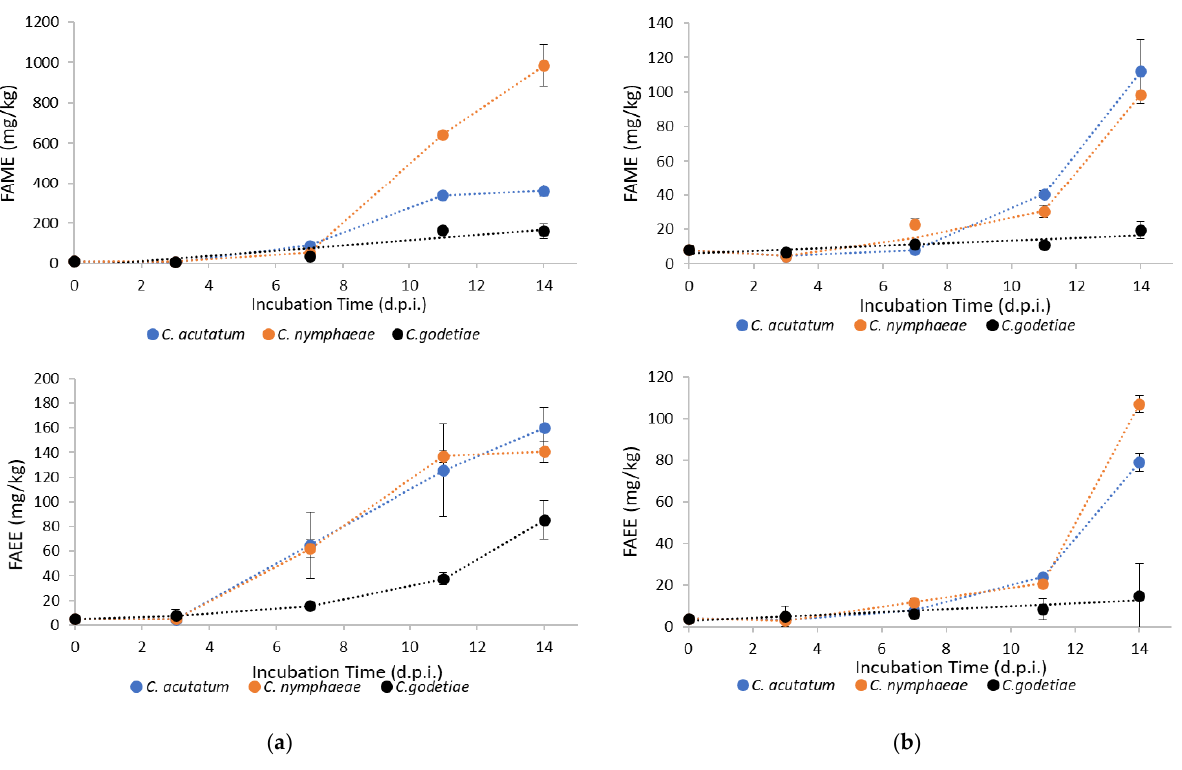
Figure 3. Total amount of FAME and FAEE of Galega ( a ) and Cobrançosa VOO ( b ) obtained from fruits, after 3, 7, 11, and 14 days post-inoculation (d.p.i.) with Colletotrichum acutatum , C. nymphaeae, and C. godetiae (mean values ± STD).